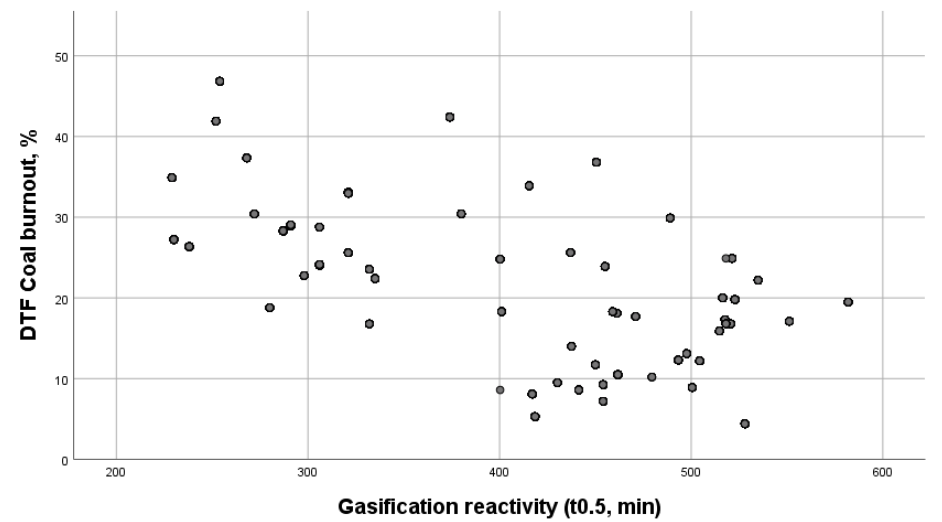
Figure 10. Scatter plot of the DTF burnouts of the injection coals versus their char gasification reac- tivities.